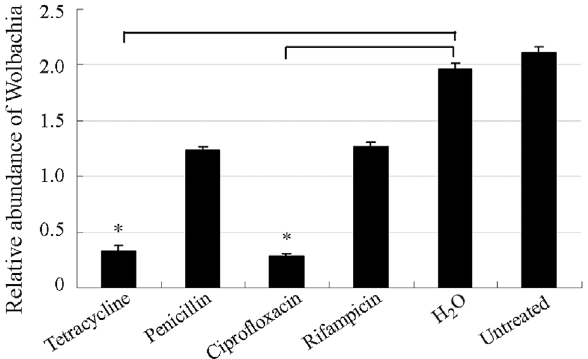
Figure 6 - Relative Wolbachia abundance after antibiotic treatments. The graphsshow Wolbachia abundancerelativetothehostsilkwormreference gene ( sw22934 ) as determined by quantitative PCR. The error bars repre- sent standard deviations.